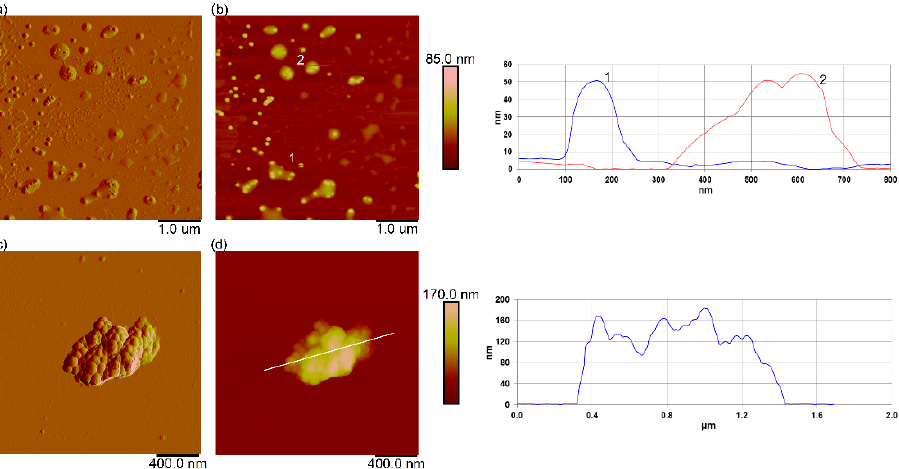
Figure 2. AFM characterization of PS-NH 2 and PS-COOH nanoplastics in natural seawater. AFM images of PS-NH 2 ( a , b ) and PS-COOH nanoplastics ( c , d ) in filtered natural seawater (50 mg L − 1 ), with corresponding vertical profiles along the indicated lines in ( b ) and ( d ), respectively. Vertical profiles of particles along indicated lines in ( b , d ) are shown next to the corresponding image (line crossing particle in ( b ) and corresponding vertical profile is shown in the same color and indicated by the same number in the corresponding vertical profile). Images are acquired using the tapping mode in air and are presented as amplitude ( a , c ) and height data ( b , d ), with scan sizes of 5 µm × 5 µm ( a , b ); 2 µm × 2 µm ( c , d ) and vertical scales of 85 nm ( b ) and 170 nm ( d ).